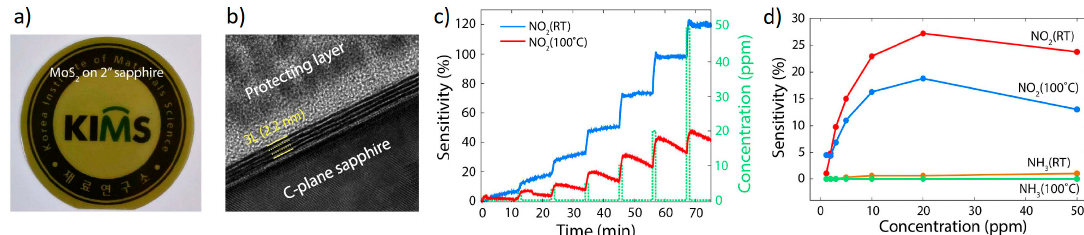
Figure 8. ( a ) Image of MoS 2 semi-transparent film on the 2” sapphire substrate. ( b ) Cross-sectional Transmission Electron Microscopy (TEM) images, demonstrating that the synthesized MoS 2 films consisted of three layers of MoS 2 . ( c ) Transient NO 2 gas response at 1.5 to 50 ppm concentration, at operating temperatures of RT and 100 °C. The recovery rate was faster at 100 °C than at RT. ( d ) Comparison of responses to NO 2 and NH 3 . Reprinted with permission from [58]. Copyright (2015) Nature Publishing Group.